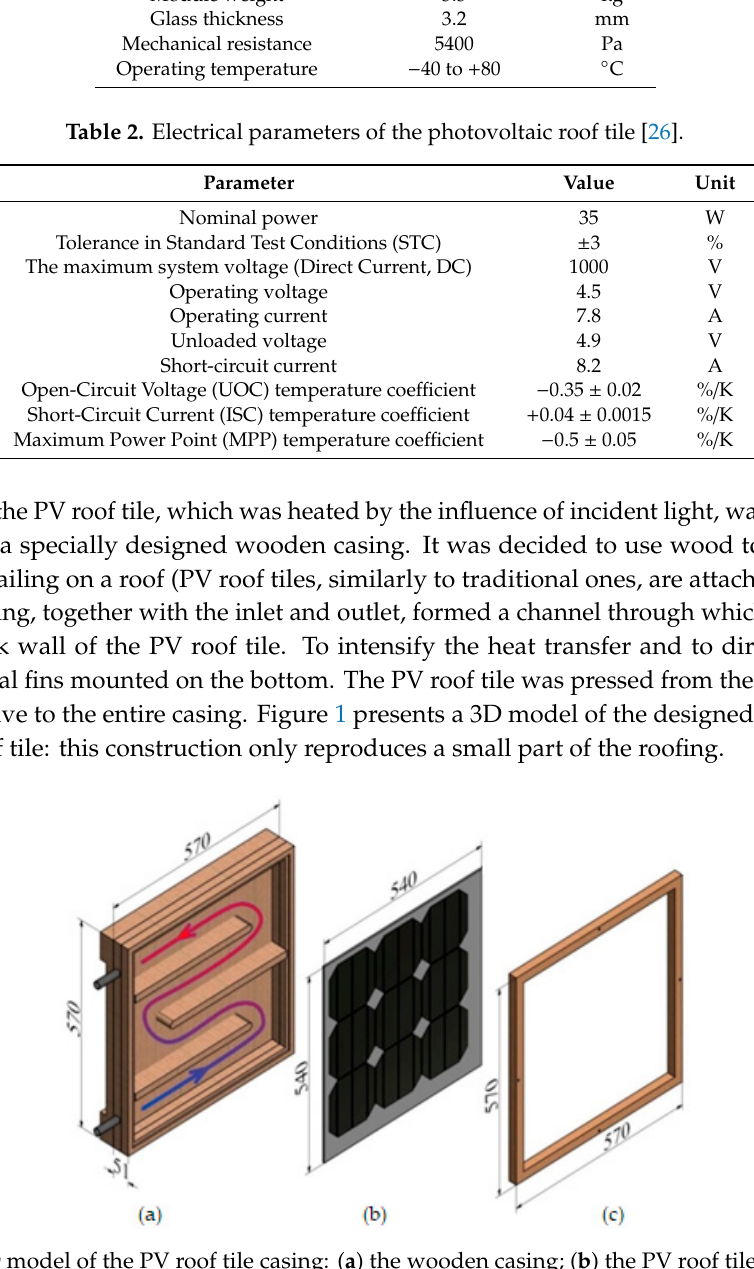
Figure 1. 3D model of the PV roof tile casing: ( a ) the wooden casing; ( b ) the PV roof tile; and ( c ) the wooden frame.